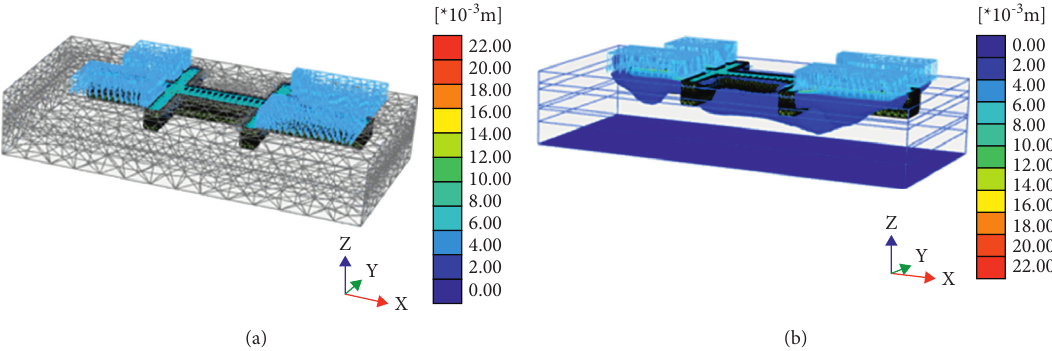
Figure 14: Influence of the application of optimum axial loading support capacities on the whole project model. (a) Total displacement. (b) Displacement isosurface.